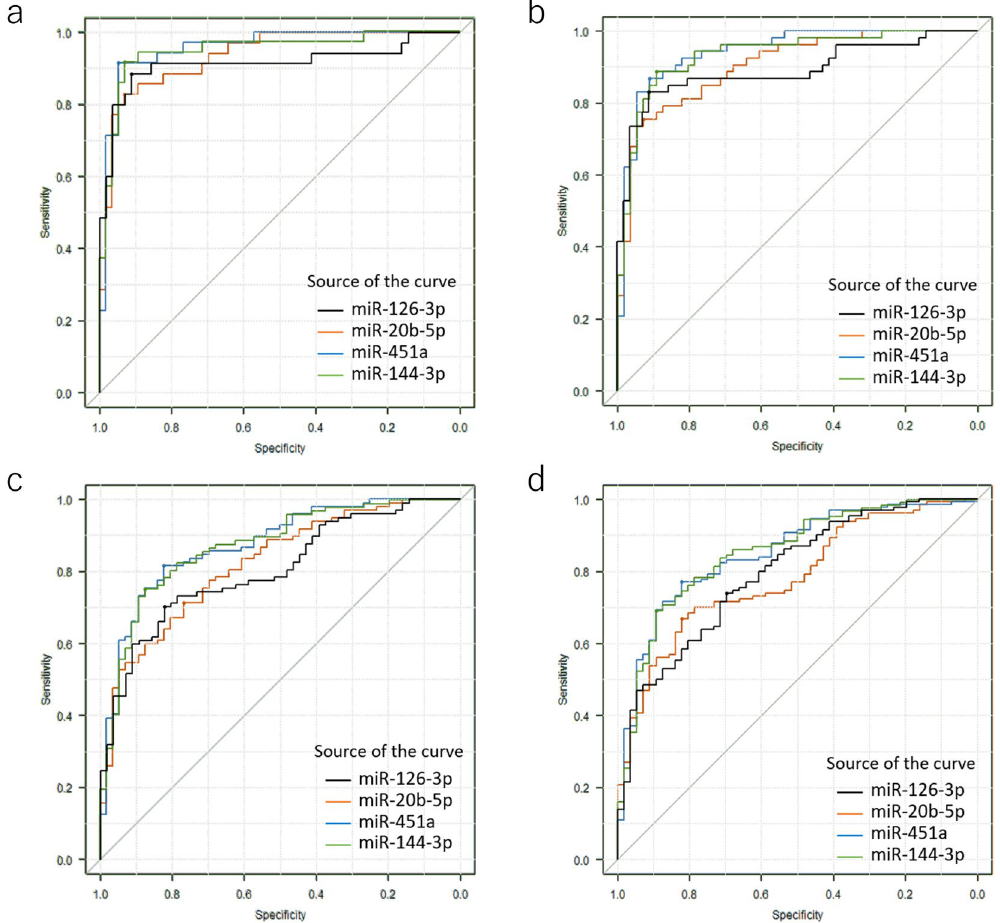
Figure 3. The conventional receiver operating characteristic (ROC) curve to analyse miRNA levels for determining the cut-off points that yielded the highest combined sensitivity and specificity from the Youden index with respect to identifying patients in the normal and disease categories. Sensitivity is indicated on the y-axis and specificity is indicated on the x-axis. Disease category: ( a ) SCC, ( b ) SCC and AD, ( c ) CIN3 + , ( d ) CIN2 + . The source of the curves is indicated in the